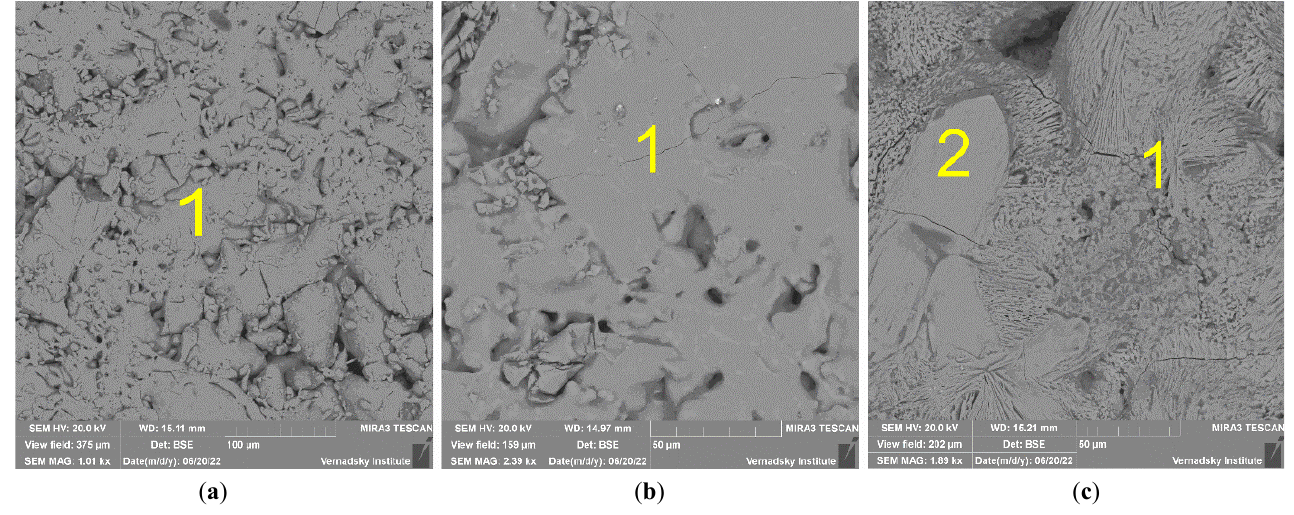
Figure 4. SEM micrographs of FP matrix samples synthesized at 550 ( a ), 650 ( b ) and 750 °C ( c ), where 1 and 2 are phosphate phases. Table 3. Average data of elemental composition (wt%) of the FP matrix according to SEM/EDS data.